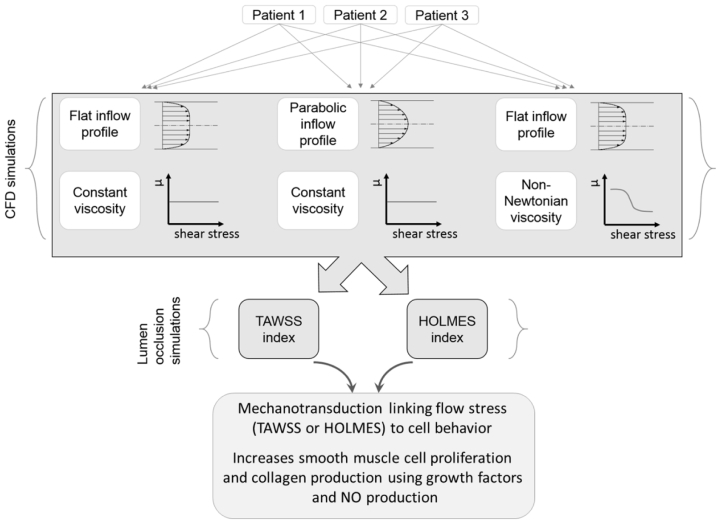
Overview of interactions. A complex interaction between mechanical stimuli on the wall affects cell behavior, with smooth cells and collagen proliferating because of growth factors and nitric oxide (NO) production. The result is the development of neointimal hyperplasia (NIH) and vascular remodeling. Details of the model are published in reference 14. CFD, Computational fluid dynamics; HOLMES, highly oscillatory, low magnitude shear; TAWSS, time-averaged wall shear stress.